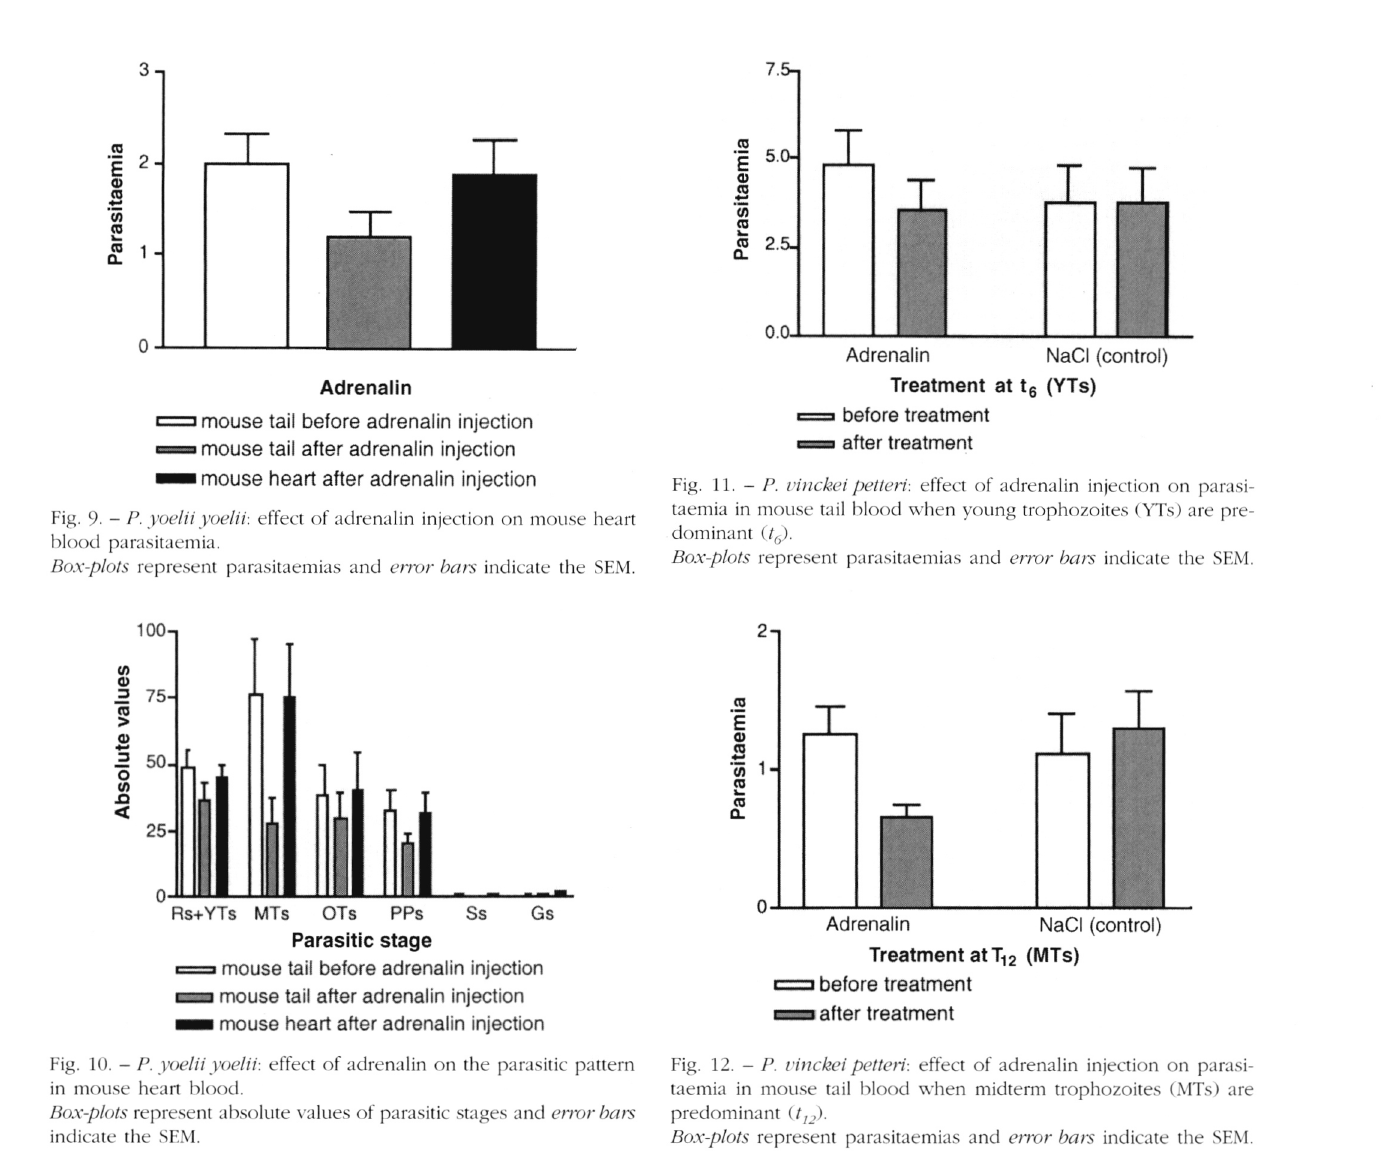
Fig. 12. - P. vinckei petteri: effect of adrenalin injection on parasi­ taemia in mouse tail blood when midterm trophozoites (MTs) are predominant ( t u). Box-plots represent parasitaemias and error bars indicate the